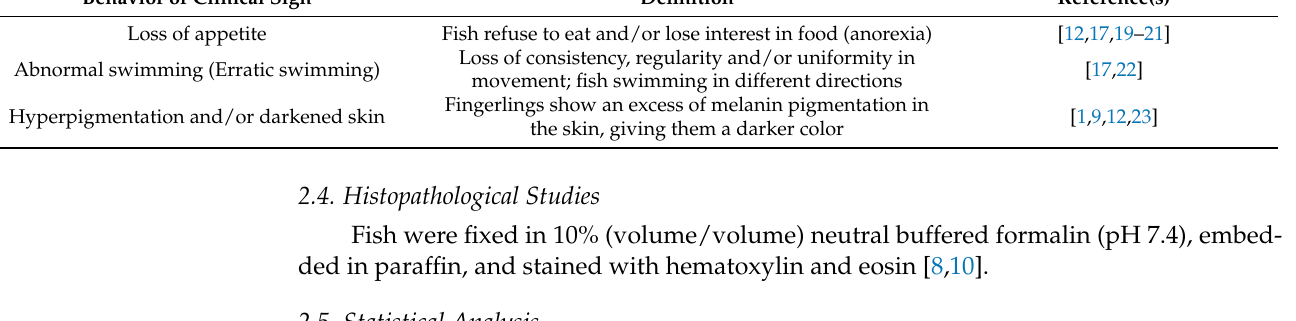
Table 1. Aeromonas species and histopathological lesions observed in nasal epithelium or rosette, telencephalon, and oblongata medulla changes (%), observed in rainbow trout fingerlings infected with Aeromonas spp. Behavior or Clinical Sign Definition Reference(s) Loss of appetite Abnormal swimming (Erratic swimming) Hyperpigmentation and/or darkened